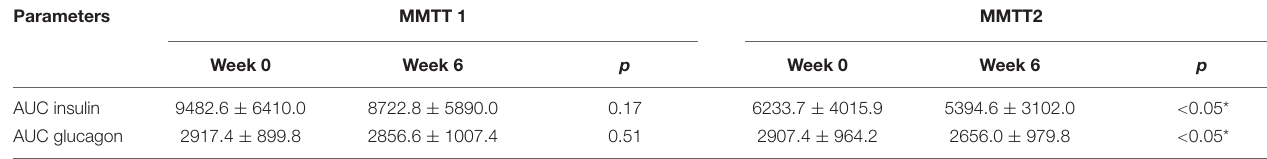
TABLE 5 | Area under the curve-insulin and AUC-GCGN levels at baseline (Week 0) and after HPD intervention (Week 6) in MMTT 1 and MMTT 2. Parameters